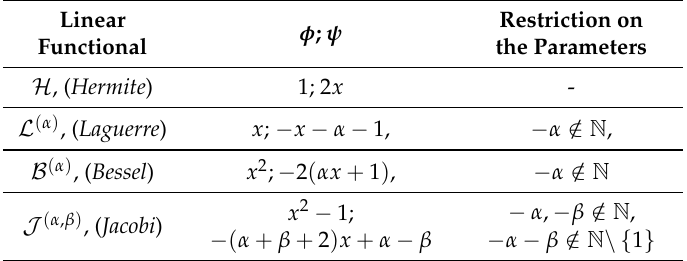
Table 1. Quasi-definite classical orthogonal polynomials.